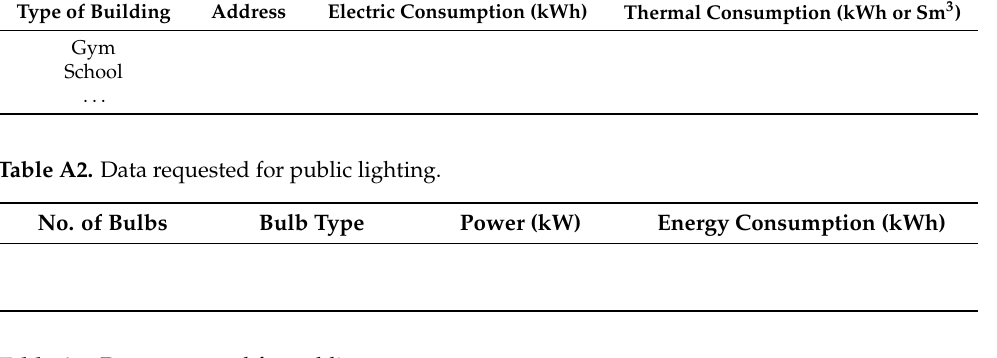
Table A3. Data requested for public transport.